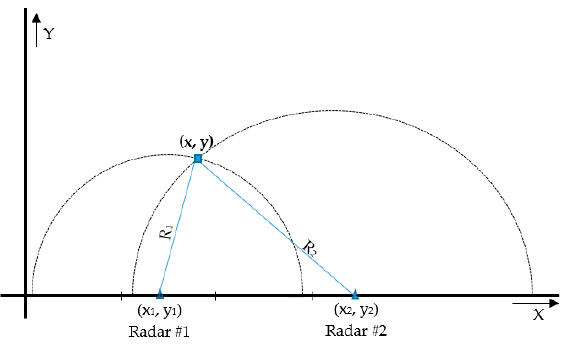
Figure 4 . 2D positioning with two radars.